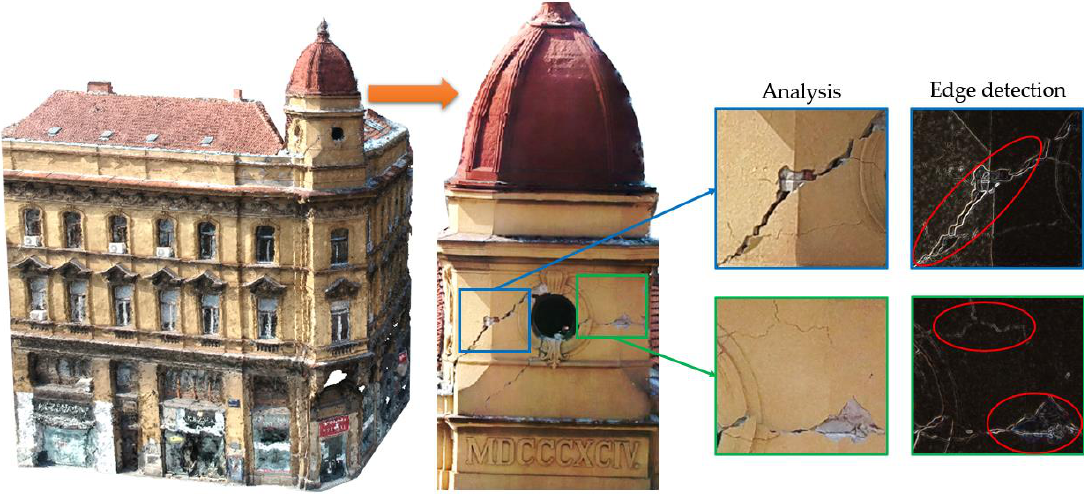
Figure 3. Automatic building damage detection and mapping based on the photogrammetric 3D methods and remote sensing techniques.